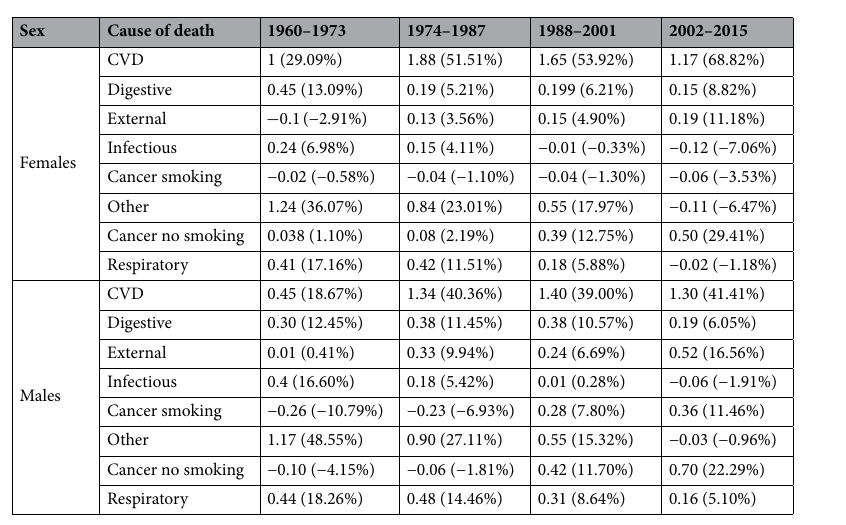
Table 1. Life expectancy absolute and percentage contributions aggregated over ages and specific by causes of